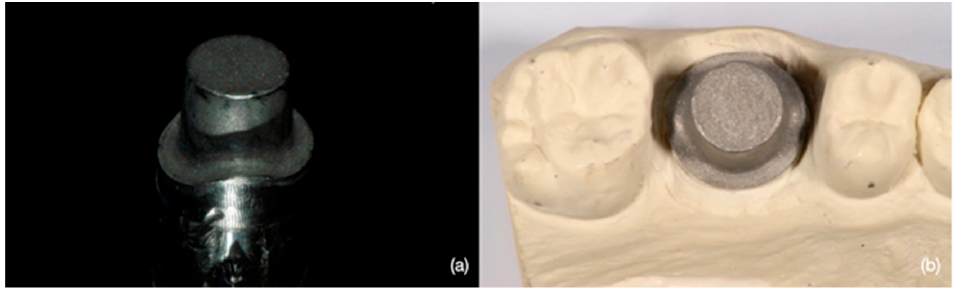
Figure 1. ( a ) The customized Cr-CO abutment generated by a 3D CAD modeling software. ( b ) The Cr-Co abutment is positioned in the model.